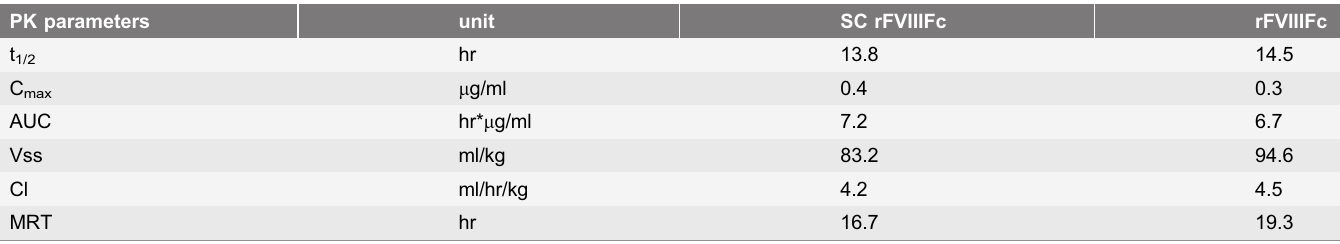
Table 4. Summary of PK parameters for SC rFVIIIFc and